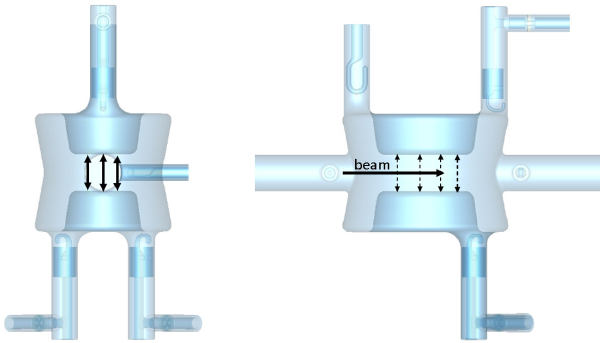
FIG. 2. Cross section views of the vertical DQW cavity and coupler design used for the beam tests in the